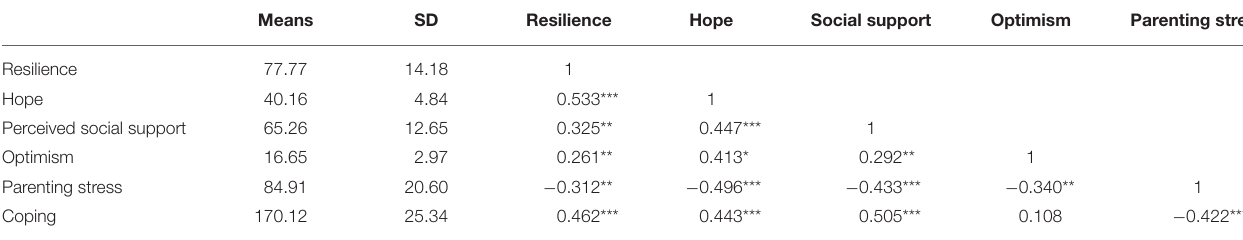
TABLE 3 | Descriptive statistics and correlations in continuous variables among fathers ( n = 69).